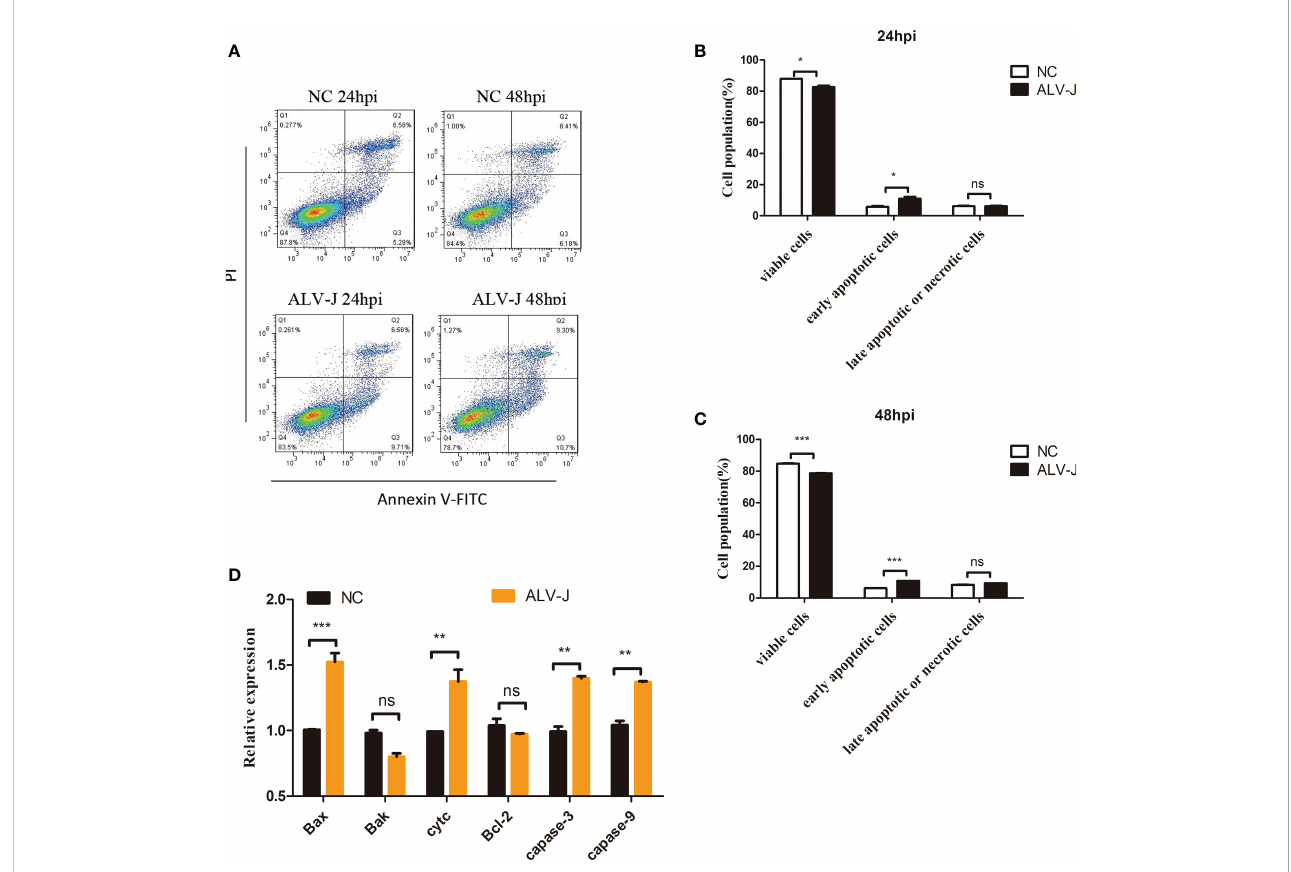
FIGURE 1 ALV-J infection induces DF-1 cells apoptosis. (A) DF-1 cells were infected with ALV-J (10 5 TCID 50 /0.1mL) for the indicated time. Normal cells (NC) with no infection as a negative control. Apoptosis of DF-1 cells was measured by fl ow cytometry. (B, C) Statistical analysis of viable cells, early apoptotic cells, late apoptotic cells or necrotic cells rate. (D) qRT-PCR analysis of apoptosis-related genes ( Bax , Cyt c , Caspase-3 and Caspase-9 , Bak , and Bcl-2) in ALV- J infected cells. hpi represents hours post infection. Data shown are the means ± SEM of at least two independent experiments. P values were calculated using unpaired Student ’ t-test. A P -values < 0.05 were considered statistically signi fi cant differences, and a P -values < 0.01 were considered highly statistically signi fi cant differences. *P < 0.05, ** P < 0.01, *** P < 0.001, ns: Non-signi fi